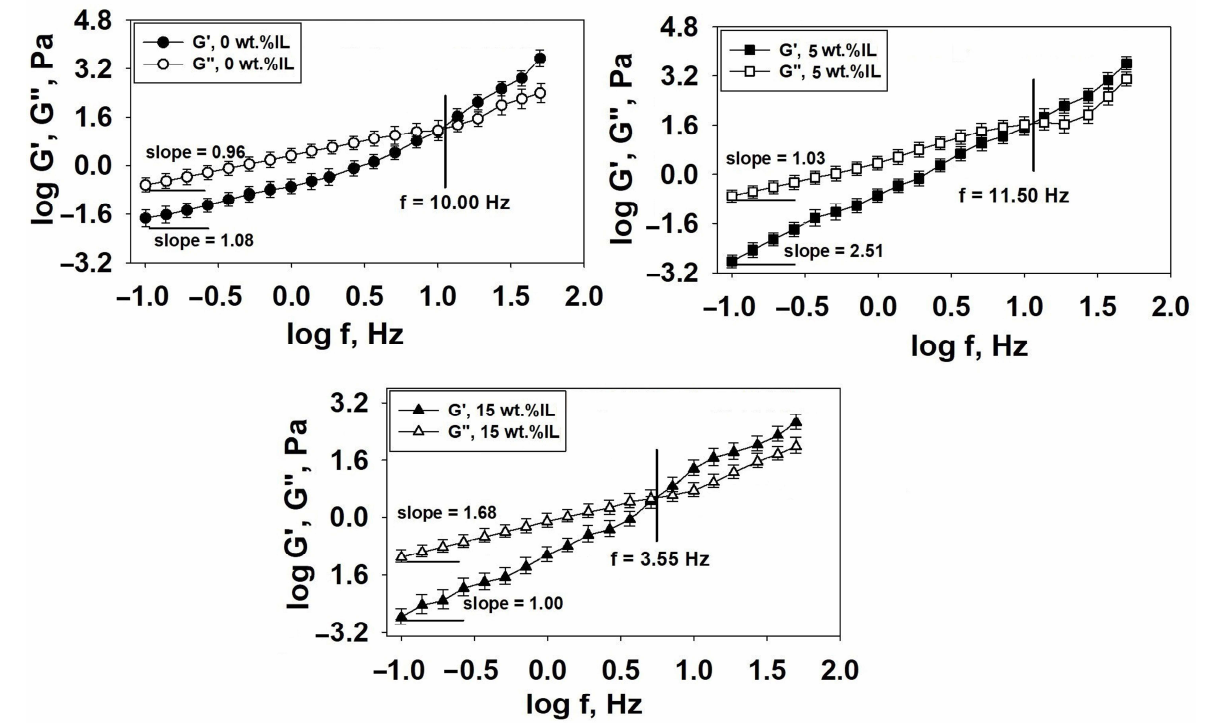
Figure 3. Logarithmic plots of storage (G’) and loss (G″) moduli versus frequency for the PSFQ/Ph-IL blend at different compositions.